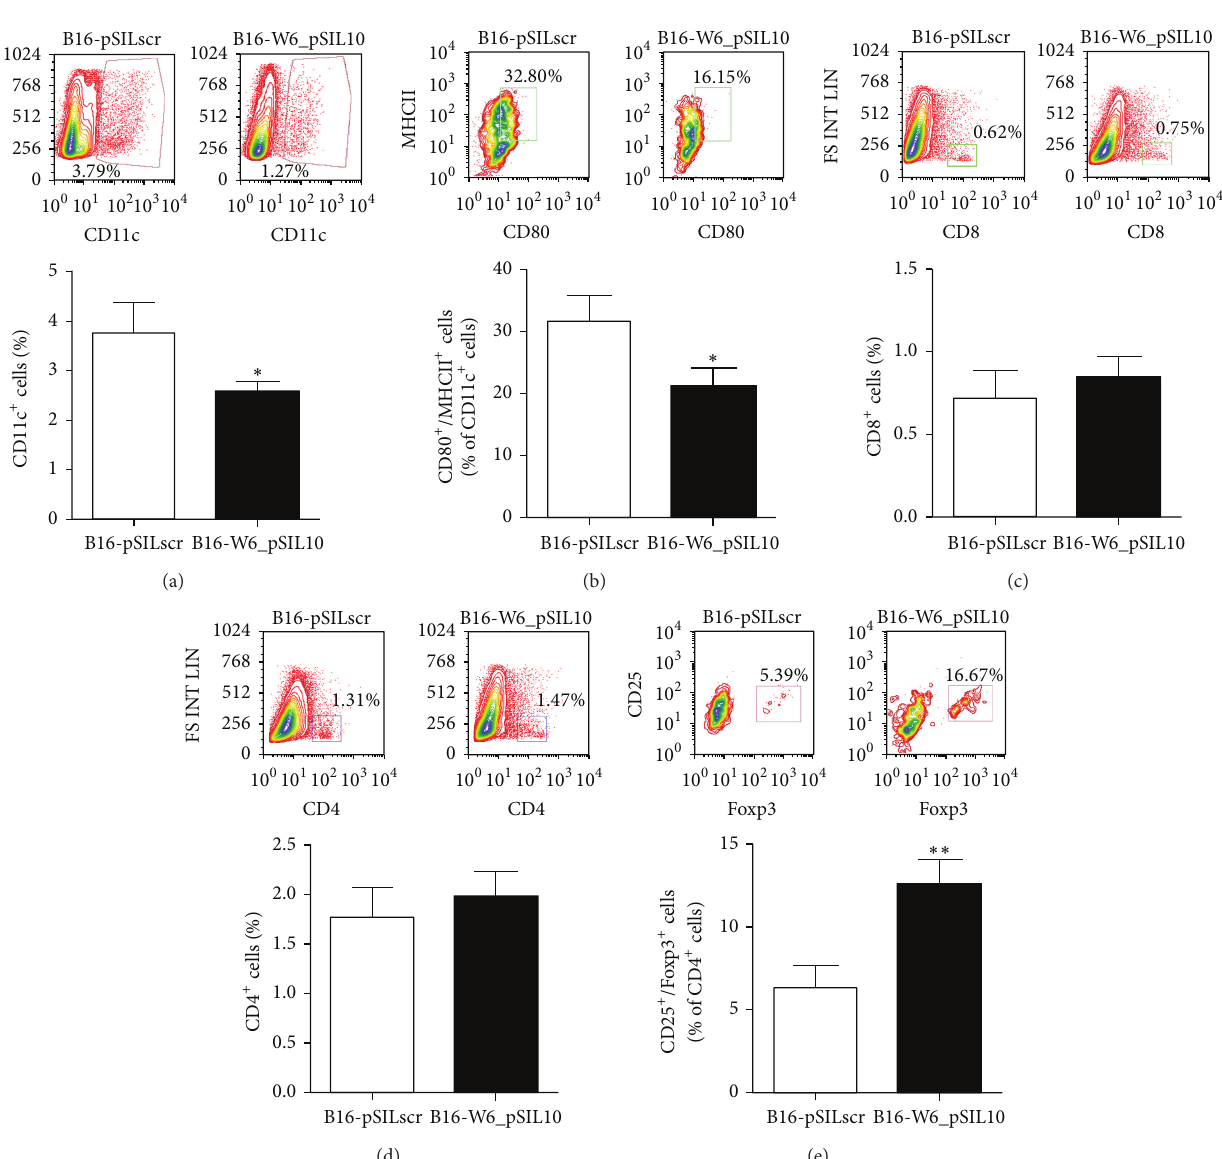
Figure2:A-SMaseinducedMDSCaccumulationdeterminesanimmunosuppressivemicroenvironment.Flowcytometryanalysisoftumour- infiltrating immune cells. Tumour cell suspensions obtained from resected tumours were stained with the specific fluorescent conjugated antibodies for CD11c, CD80, MHCII, CD8, CD4, CD25, and Foxp3 antibodies. (a) A representative dot plot of gated CD11c + cells is shown ( upper panel ). The histograms represent the data obtained from ten to fifteen animals per experimental group ( lower panel ). (b) A representative dot plot of CD80 + /MHCII + cells in the CD11c + cell population is shown ( upper panel ). The histograms represent the data obtained from ten to fifteen animals per experimental group ( lower panel ). (c-d) A representative dot plot of CD8 + cells (c) and CD4 + cells (d) is shown ( upper panel ). The histograms represent the data obtained from ten to fifteen animals per experimental group ( lower panel ). (e) A representative dot plot of CD25 + /Foxp3 + in the CD4 + cell population is shown ( upper panel ). The histograms represent the data obtained from ten to fifteen animals per experimental group ( lower panel ). Values in each histogram are expressed as mean ± SEM. ∗ 𝑃 < 0.05 ; ∗∗ 𝑃 < 0.01 versus B16-pSILscr